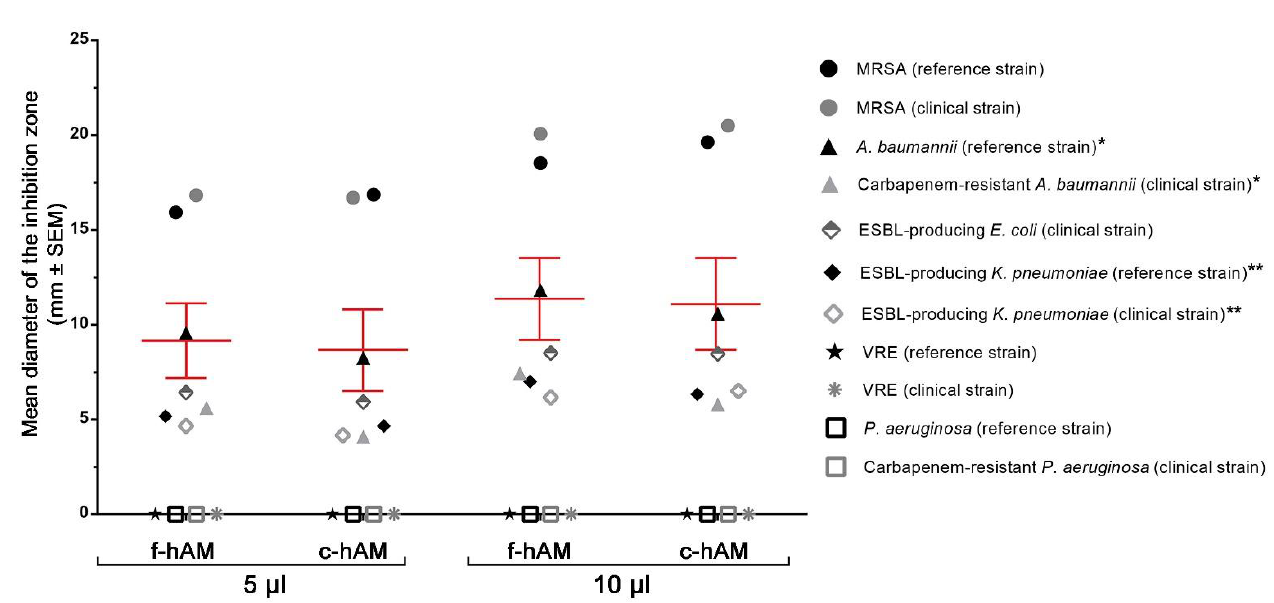
Figure 3. The range of antibacterial activity of f-hAM and c-hAM homogenates varies between the multidrug-resistant strains. The average antibacterial activity of f-hAM and c-hAM homogenates against all the susceptible strains is shown. The bars (red) show the mean diameter of the inhibition zone ± SEM (mm) of all the susceptible strains. On average, the application of f-hAM homogenate resulted in a larger inhibition zone than the application of c-hAM homogenate. Furthermore, a larger volume of hAM homogenates applied (10 µ l) resulted in a larger inhibition zone than the smaller volume of hAM homogenates (5 µ l). (*, **) Antibacterial activity of f-hAM and c-hAM homogenates was detected in 75% (*) or 25% (**) of all the performed tests and only these measurements were included in the mean diameter ± SEM (mm) of the inhibition zones. Table 2. The range of antibacterial activity of f-hAM and c-hAM homogenates varies between multidrug-resistant strains.